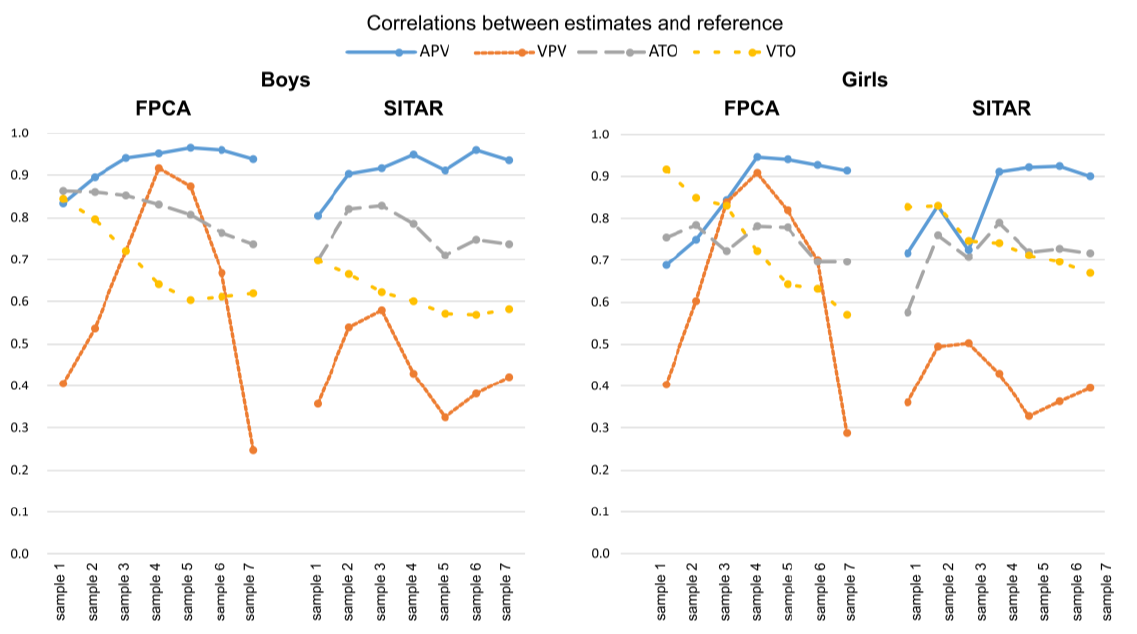
Figure 6. Sex-specific Pearson product moment correlations between estimates and the reference for growth milestones (APV, VPV, ATO, VTO) for each method and testing sample.